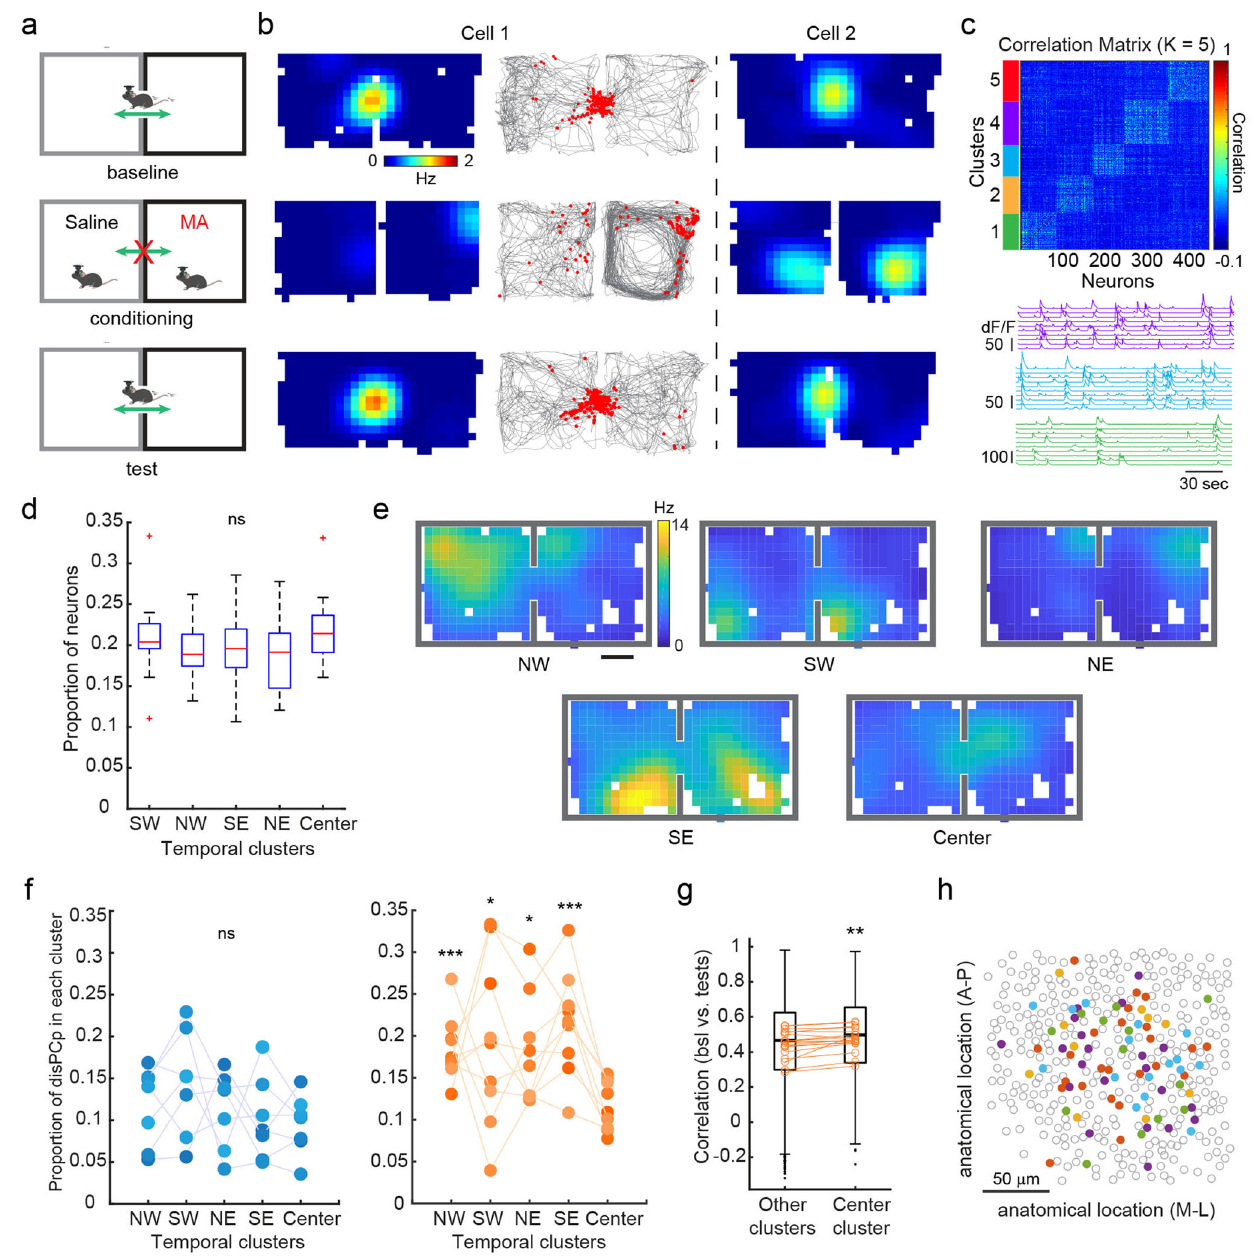
Fig. 5 | disPCp in MA mice emerge in an experience-dependent manner. a Schematicillustratingananimal ’ spossiblelocationinbaseline,conditioning,and testsessions. b TwoexampleneuronsthataremaximallyactiveattheCPPjunction. Sessions organized as labeled in ( a ). Both rate map (warmer colors indicate higher fi ring rates) and raster plot (red calcium events on top of gray running trajectory) areshownforcell1. c Top,the temporalcorrelationmatrixof calcium signals from baseline of an example mouse, sorted by k-means derived temporal clusters. Bot- tom,synchronizedcalciumactivityforrepresentativeneuronsfromthreedifferent clusters (colors correspond to the top panel). d The proportion of neurons assigned to each cluster (F(4,75)=1.77, p =0.14, one-way ANOVA, n =16 mice from CtrlandMAgroups).Boxplot:centerindicatesmedian,boxindicates25thand75th percentiles, whiskers extend to the most extreme data points without outliers. Outliers are shown in red plus symbol. SW, southwest; NW, northwest; SE, south- east; NE, northeast. ns, not signi fi cant. e Summed ensemble rate maps of tempo- rally clustered disPCp from an MA mouse. f disPCp showed a non-random distribution across temporal clusters in MA (orange) but not Ctrl (blue) mice